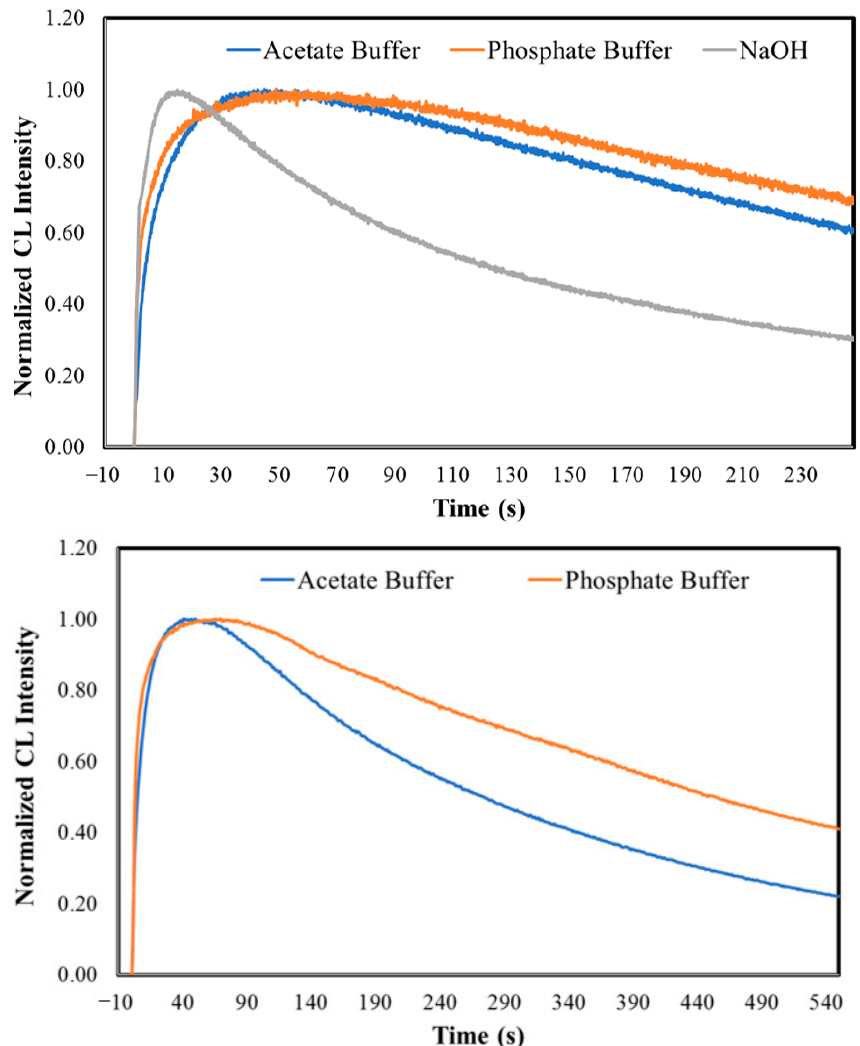
Figure 3. Normalized CL kinetic profiles for MeOBr-Cla in DMF with the addition of either sodium acetate buffer pH 5.2 (1%), phosphate buffer pH 7.4 (75 mM), or NaOH (0.1 M), measured with an integration time of 0.1 s (top). Normalized CL kinetic profiles for MeOBr-Cla in DMF with the addition of either sodium acetate buffer pH 5.2 (1%) or phosphate buffer pH 7.4 (75 mM), with an integration time of 1 s (bottom). All assays were performed with a final volume of 500 µ L and a concentration of 10 μ M of MeOBr-Cla.